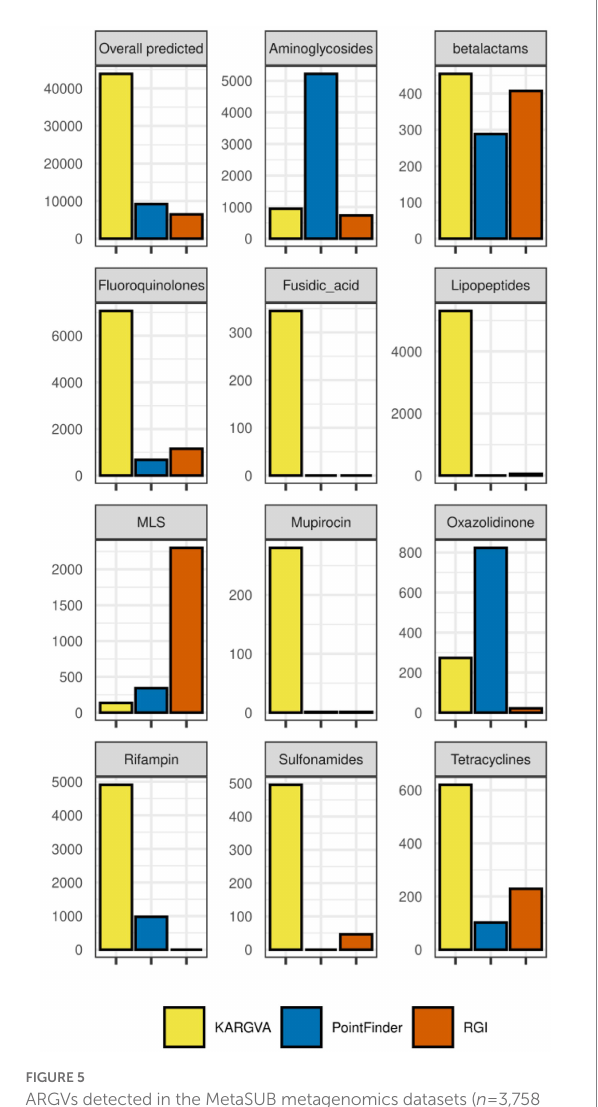
with available metadata) by KARGVA, RGI, PointFinder, both overall and per